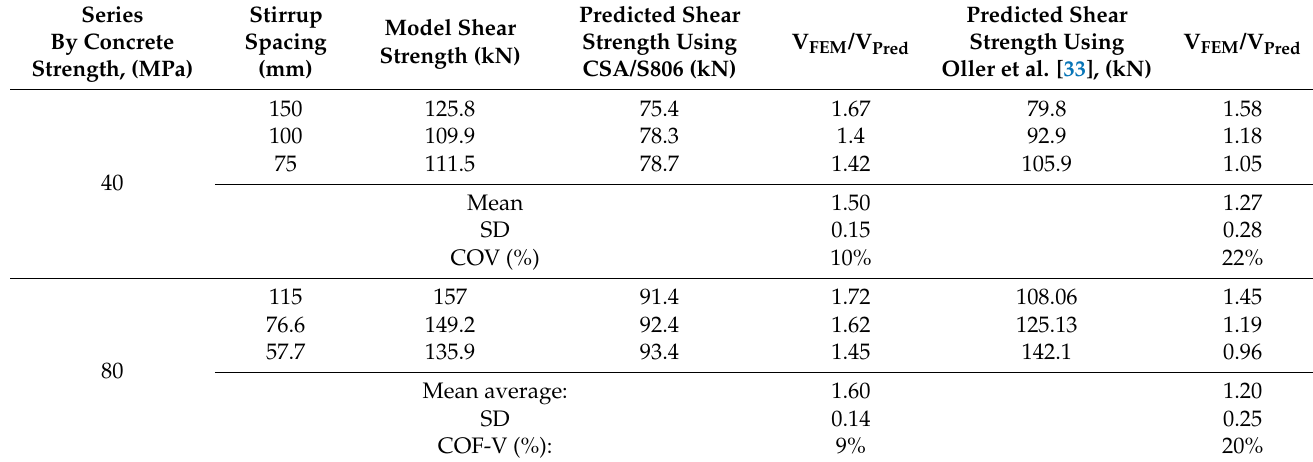
Table 5. FEM results and predicted shear strength for beam specimens of concrete strength 40 and 80 MPa with variable stirrup